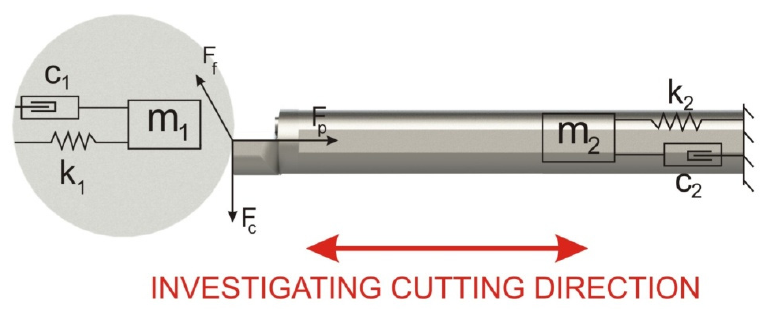
Figure 5. Model of the tool-cutting force-workpiece system.